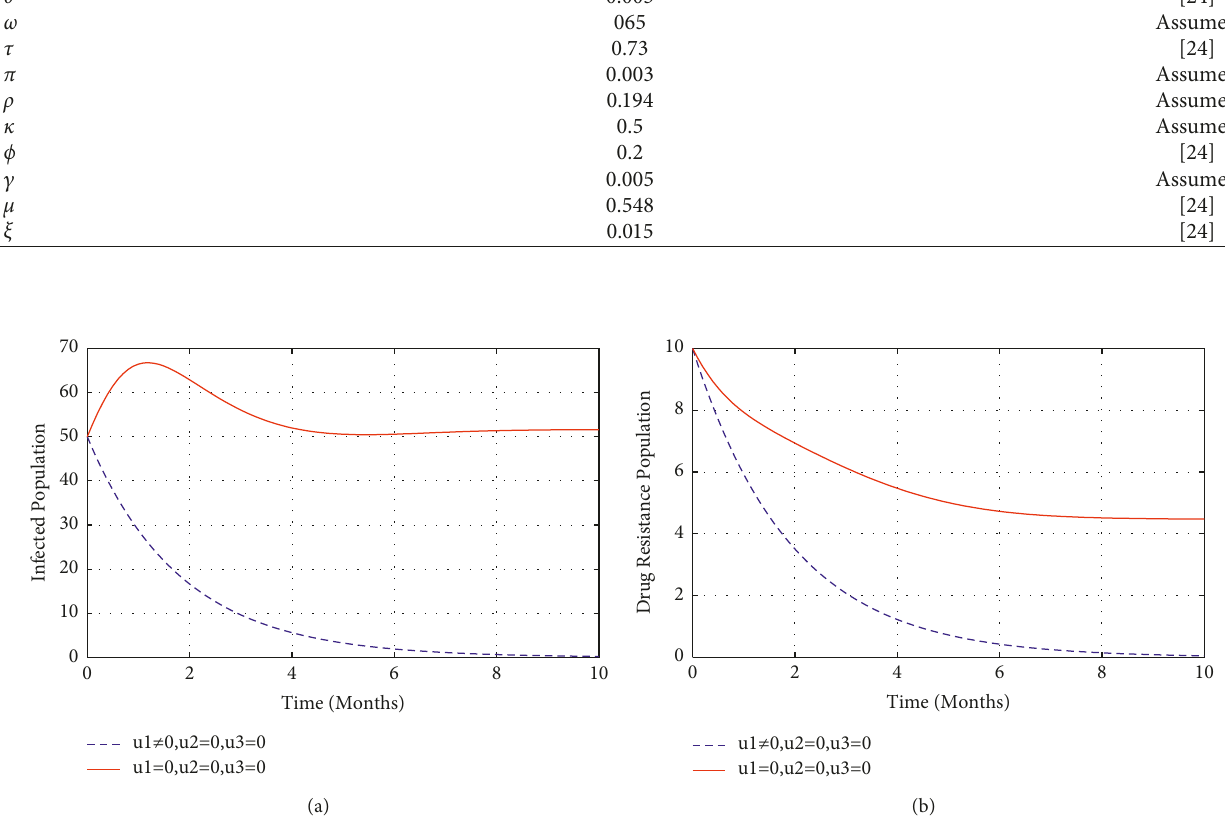
Figure 2: Impact of education on infectious and drug resistance populations.